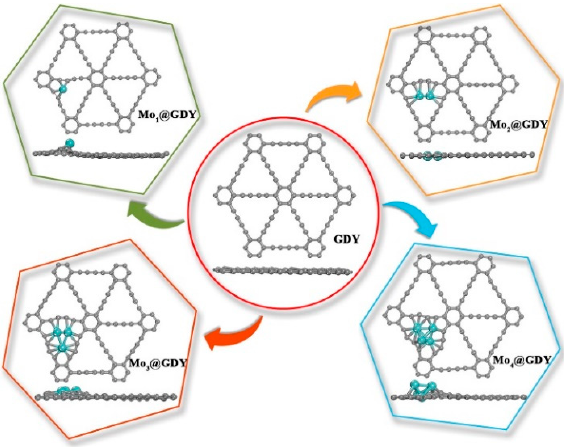
Figure 5. Simulated structures for GDY and Mo x @GDY from a planar and vertical view. Reprinted with permission from [76]. Copyright 2021 American Chemical Society.